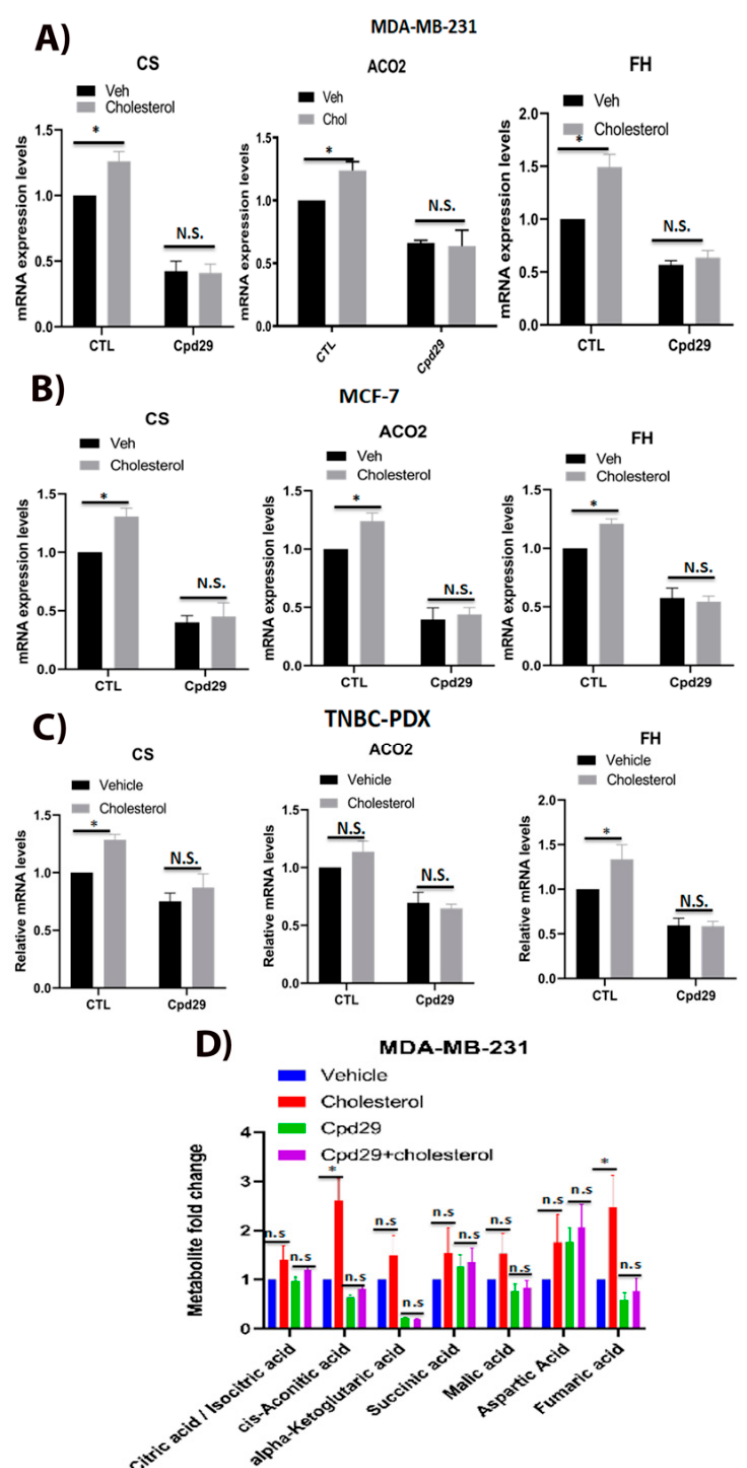
Figure 3. Cholesterol enhances the levels of three key enzymes and the abundance of two metabolites of TCA cycle in an ERR α -dependent manner. ( A – C ) MDA-MB-231 cells were treated with vehicle (Veh), cholesterol (Chol, 5 μ M), and/or cpd29 (5 μ M) for 48 h. Additionally, MCF-7 and TNBC-PDX cells were treated with vehicle (Veh), cholesterol (Chol, 10 μ M), and/or cpd29 (10 μ M) for 48 h. Total RNA was extracted and analyzed using RT-qPCR. The genes analyzed: CS: citrate synthase, mitochondria, ACO2: aconitase 2, mitochondria, and FH: fumarate hydratase. The mRNA data were normalized to endogenous GAPDH. Ctl (control) represents the breast cancer cells treated with cholesterol or vehicle in the absence of cpd29. ( D ) The metabolic profiling of